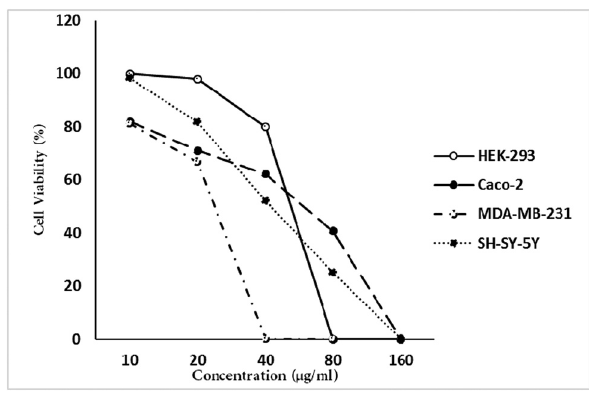
Figure 2: Anti - proliferative activity of ZnO - NPs. SH - SY5Y, HEK 293, Caco - 2, and MDA - MD - 231 cell lines were treated with di ff erent concentrations of ZnO - NPs ( 5, 10, 20, 40, 80, 160, 320, 640 µg/mL ) for 48 h and subjected to MTT assay and cell viability was calculated.